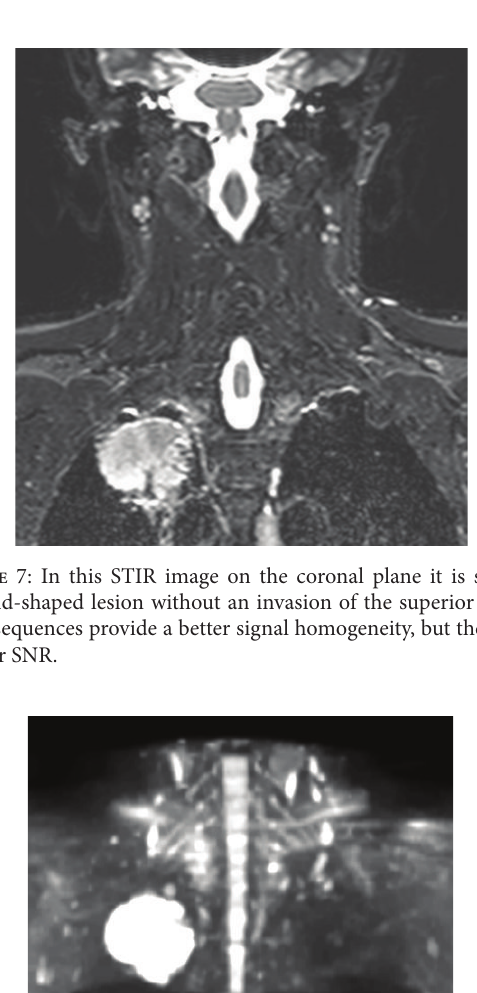
Figure 6: The use of TSE T2W sequences with a fat-signal suppres- sion is mandatory in the study of the brachial plexus. Images on the coronal plane (A) provide the possibility to study the entire superior sulcus and to evaluate its integrity in case of Pancoast tumor. The opportunity to process digital images also allows obtaining a magnification for a better assessment of the brachial plexus and a vascular invasion (B).